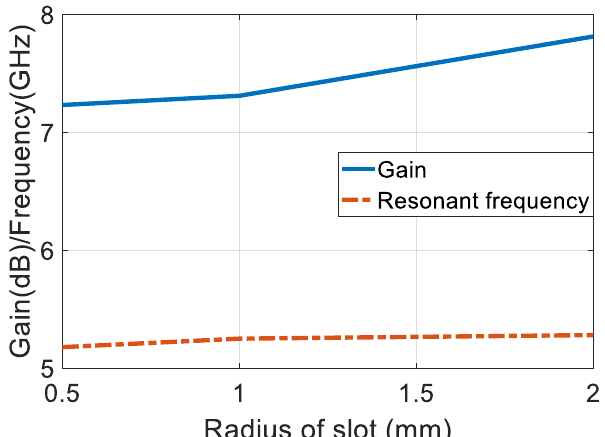
Figure 3: Variation of gain and resonant frequency with radius of